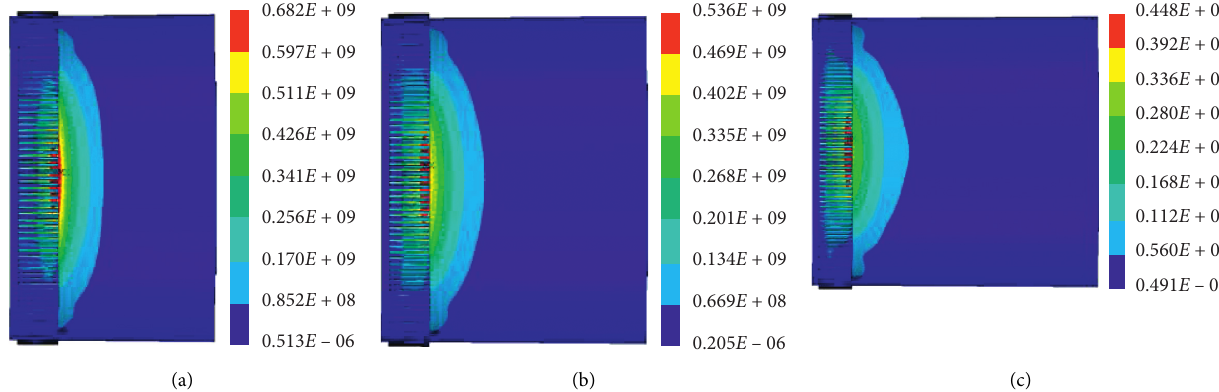
Figure 11: Flexspline stress cloud chart of different round lengths. (a) L � 50mm. (b) L � 65 mm. (c) L � 85 mm.